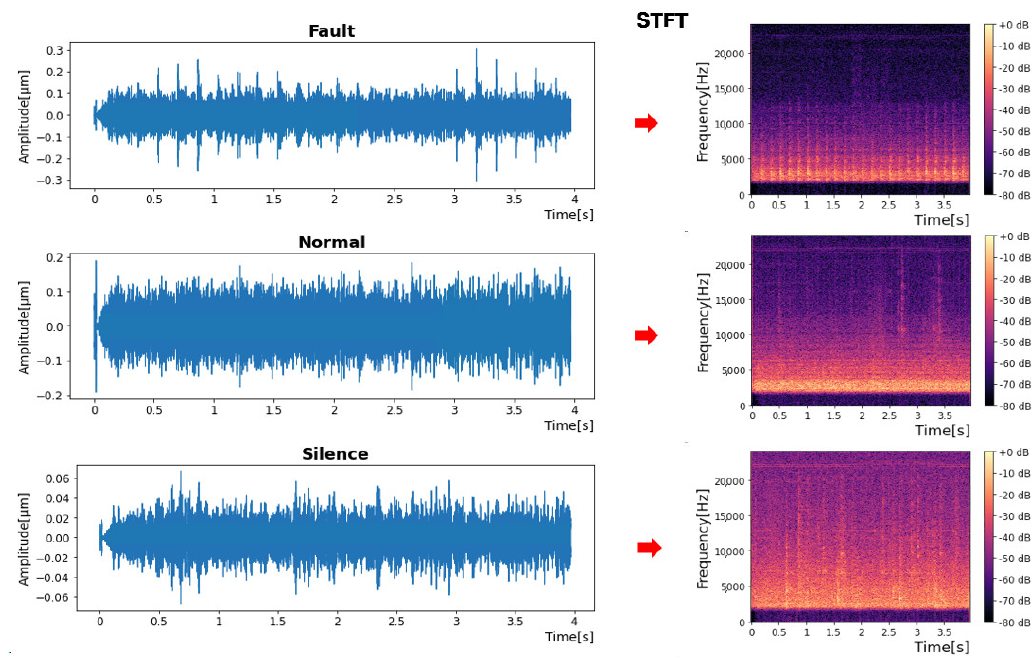
Figure 8. Spectrogram image generation.